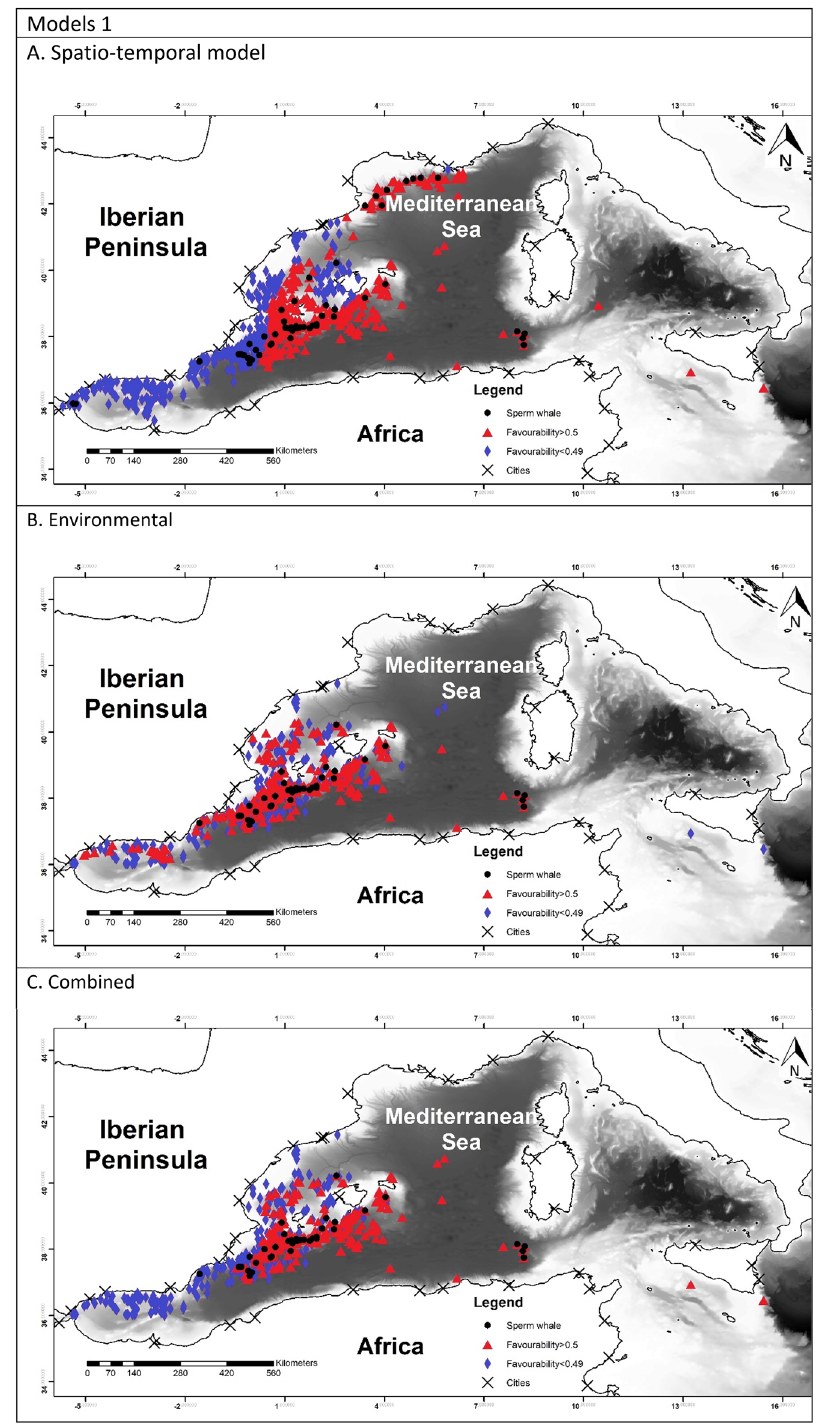
Figure 2. Maps representing the favourability calculated for each model. Black dots represent the presences of the species modelled. Blue triangles represent the locations with the favourability higher than 0.5 and red diamonds represent favourability lower than 0.5. Maps were generated using ArcGIS 10.6 (source: Esri, DigitalGlobe, GeoEye, Earthstar. Geographics, CNES/Airbus, DS, USDO, USGS, AeroGRID, IGN, and the GIS User Community: www. esri.